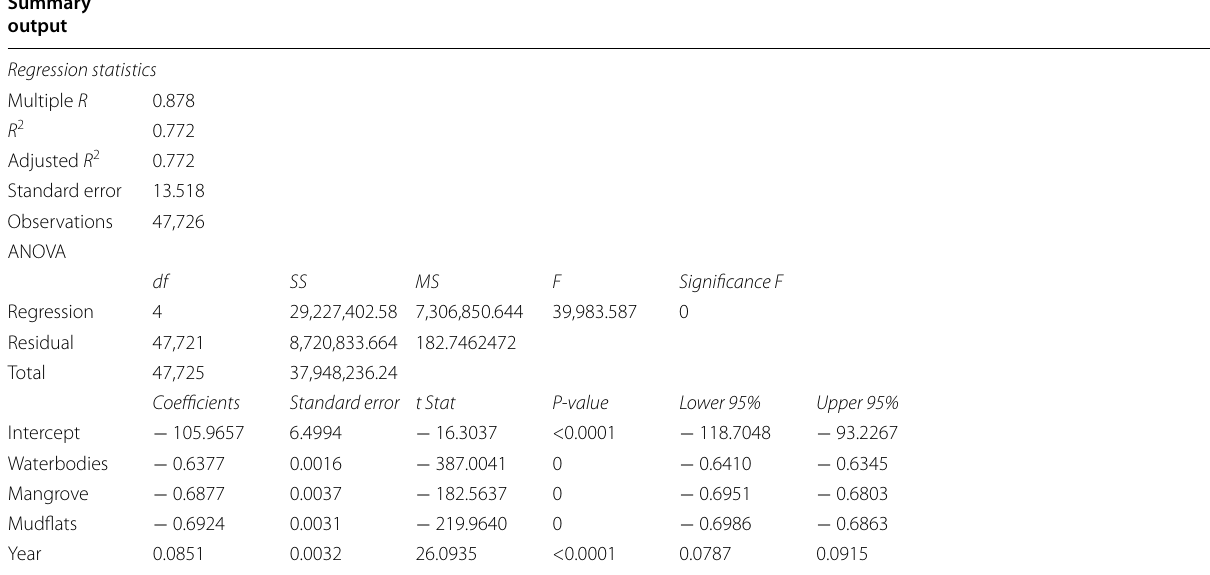
Table 6 Summary output of panel data regression model Summary